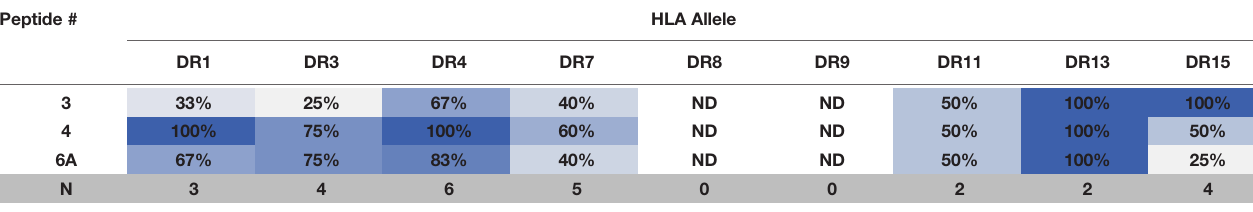
TABLE 3 | High percentages of VAC057 donors, by matched HLA-DR allele, recall three RH5 class II clusters located in the N-terminal region of the protein. Peptide # HLA Allele